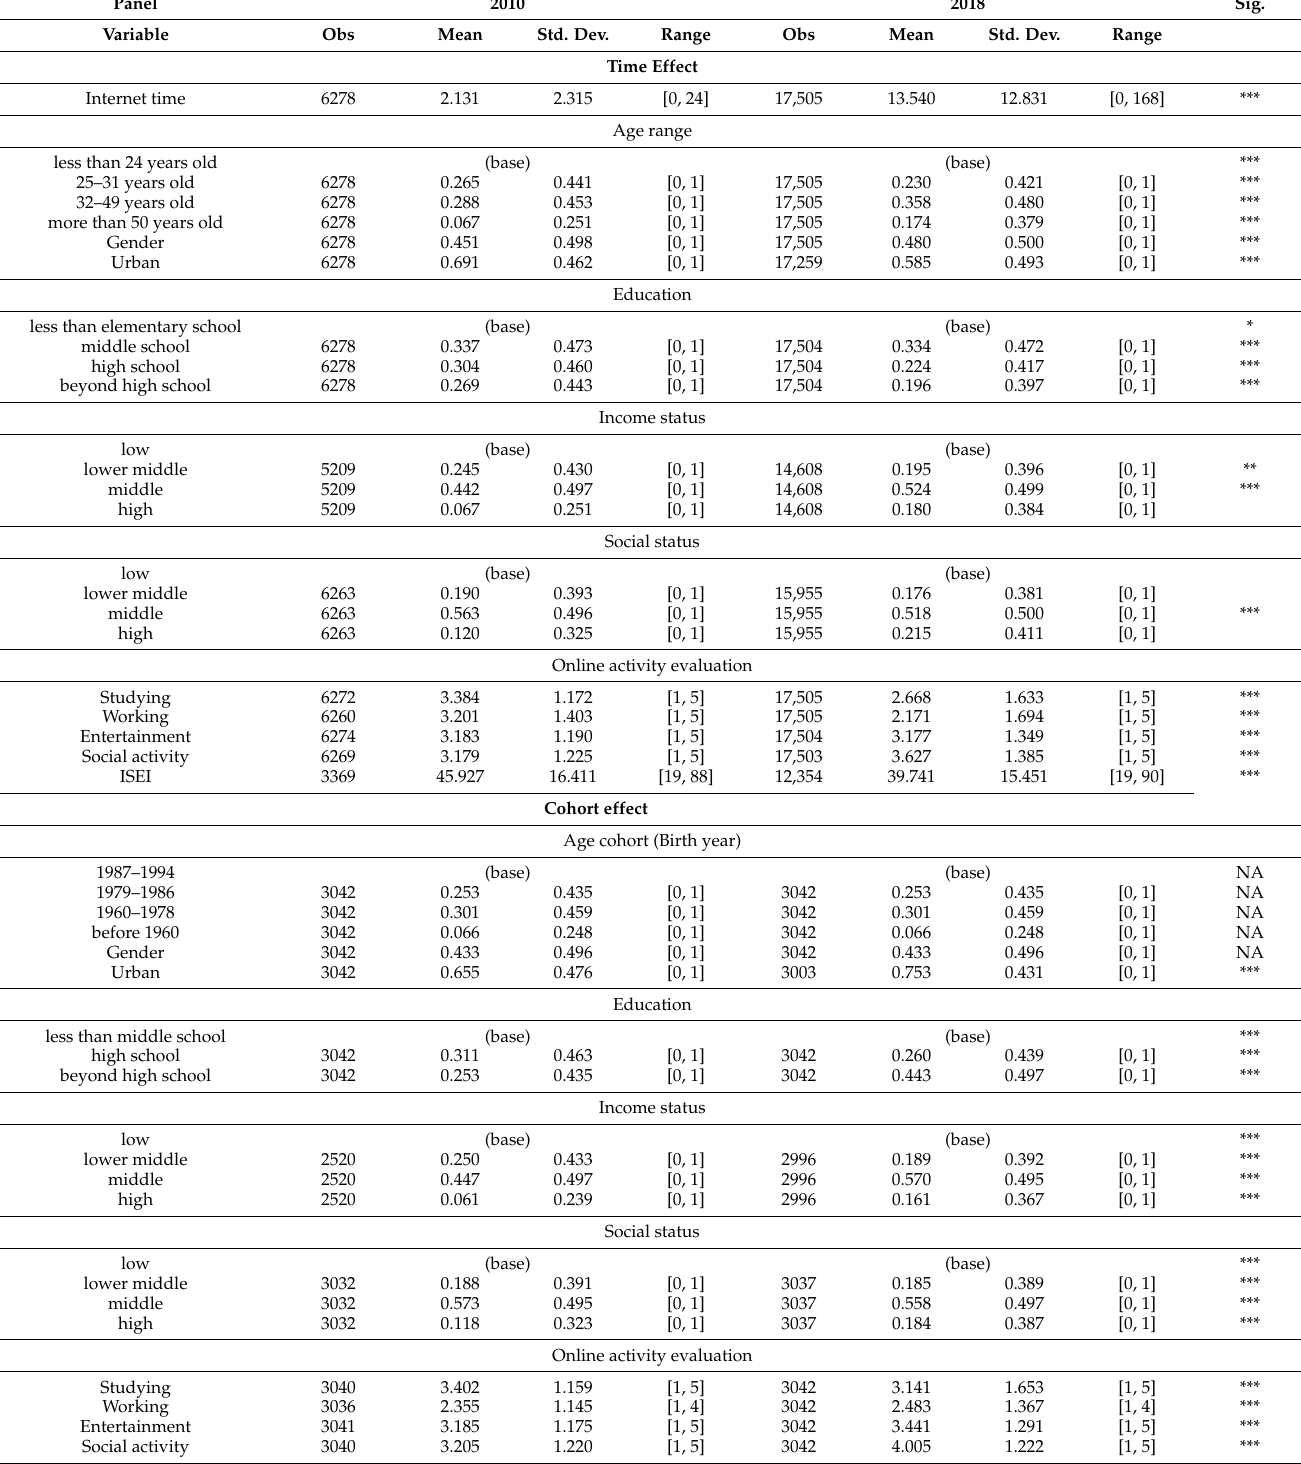
Table 1. Descriptive statistical analysis of the